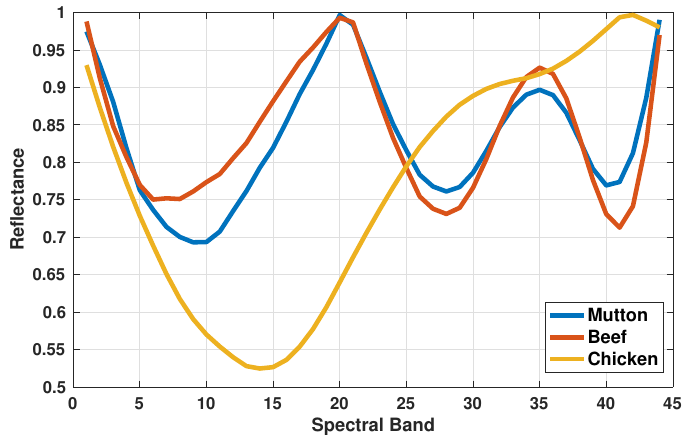
Figure 6. Reduced spectrum of minced meat, representing Myoglobin pigments (Mb) pigments information for each minced meat